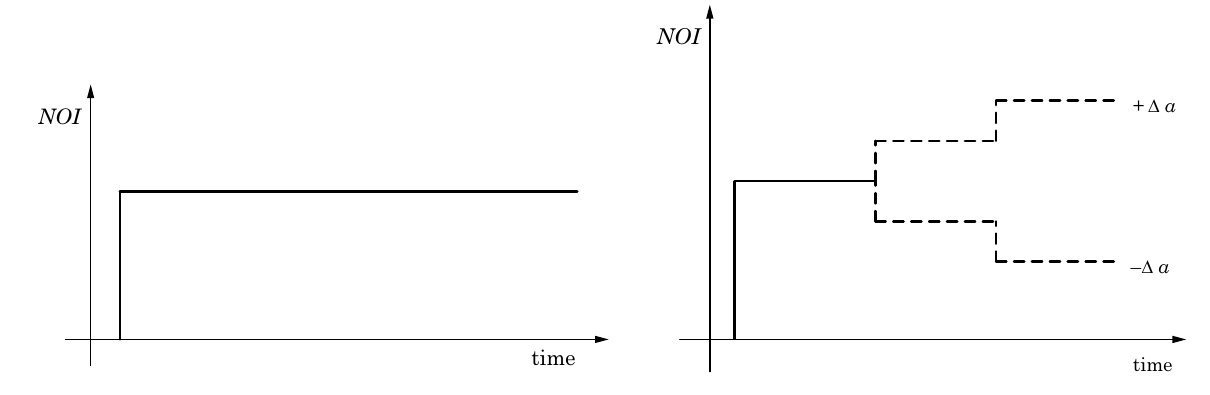
fig. 1. Direct capitalization based on the direct capitalization (formula 1)